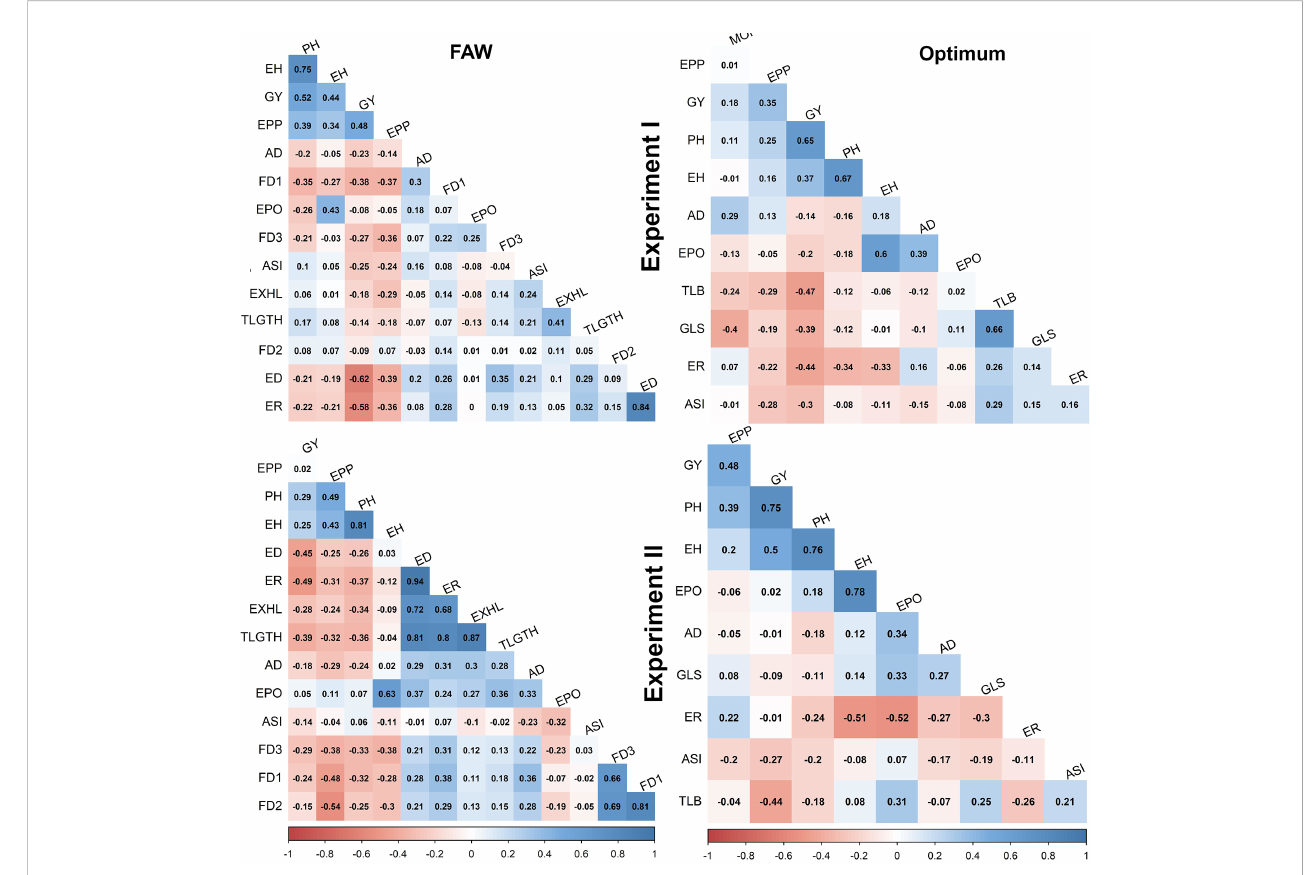
FIGURE 1 Trait correlations under FAW infestation and optimum management conditions in experiment I and II. The correlation level is color-coded according to the color key indicated on the scale. Correlations with >0.15 and >0.19 were signi fi cant at 0.05 and 0.01 levels, respectively. AD, days to 50% anthesis; ASI, anthesis to silking interval; ED, ear damage; PH, plant height; EH, ear height; GY, grain yield; FD1, FD2, FD3, mean leaf damage scores 7,14 and 21 days after arti fi cial infestation respectively; t/ha, tons per hectare; TLB, turcicum leaf blight; GLS, grey leaf spot.; ER, ear rot; EXHL, number of exit holes; TLGTH, tunnel length; EPO, ear position; EPP, ears per plant; MOI, moisture